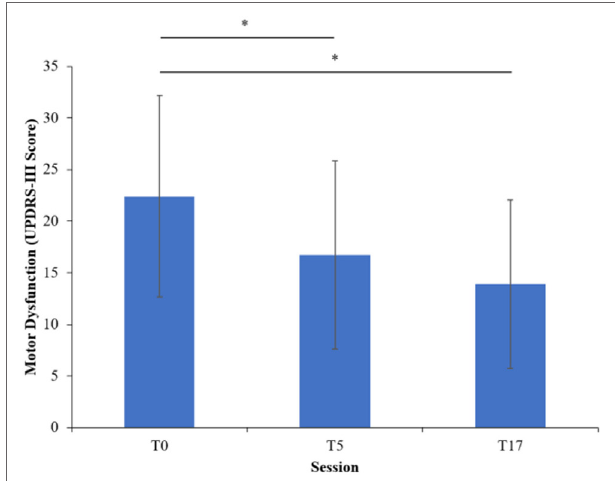
FigUre 1 | Motor dysfunction at each session of the program. Error bars indicate one SD above and below the mean. Asterisks (*) highlight significant differences ( p < 0.05).